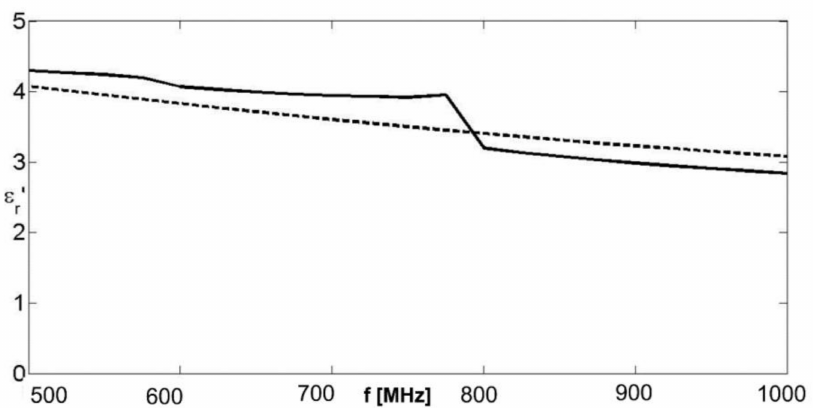
Figure 7. Real part of the equivalent complex permittivity for a Deybe dispersion law. Solid line: retrieved value; dashed line: actual value.